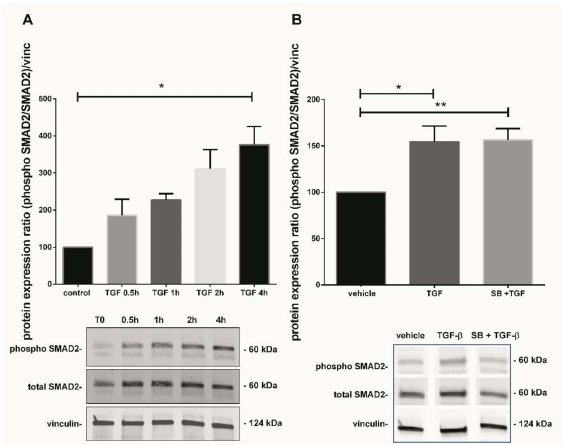
Figure 4. Effect of TGF- β 1 on SMAD2 activation. ( A ) Kinetic of SMAD2 phosphorylation in 7–9 GW chorionic villi exposed to TGF- β 1 at different times. The results are expressed as the phosphorylated SMAD2/total SMAD2 ratio and normalized on vinculin expression. Data are expressed as percentage of the control (T0) and represented as median +/ − interquartile, n = 3 different placentas. * p < 0.05, Friedman test was applied; ( B ) Phosphorylation of SMAD2 protein in chorionic villi exposed to TGF- β 1 for 48 h or SB203580 during 1 h prior to TGF- β 1 treatment. Results are expressed as the phosphorylated SMAD2/total SMAD2 ratio and normalized on vinculin expression. Data are expressed as percentage of vehicle and represented as mean +/ − SEM, n = 7 different placentas. * p < 0.05, ** p < 0.01, RM one-way ANOVA was applied. Control refers to untreated chorionic villi and vehicle refers to DMSO